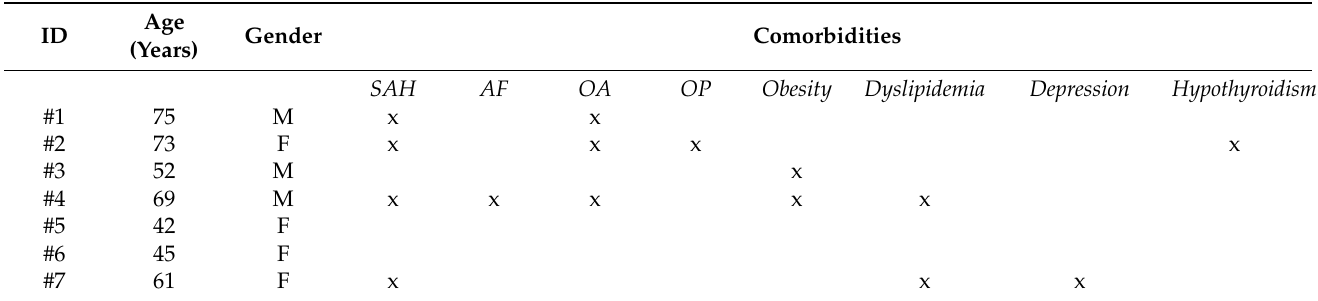
Table 1. Demographic characteristics and comorbidities of patient cohort.